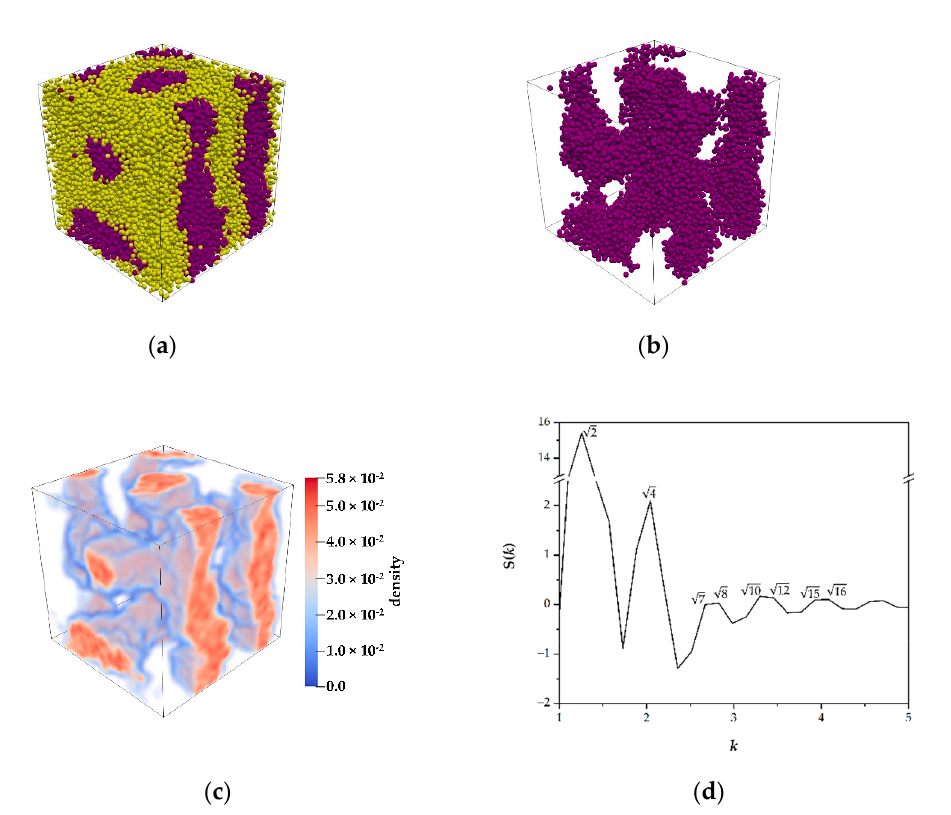
Figure 4. The coarse-grained model obtained from an S 14 I 6 : ( a ) an arrangement of the styrene (yellow) and isoprene (violet); ( b ) isoprene beads resulting solely in a skeleton of gyroidal morphology; and ( c ) a gradient of styrene density. The red regions correspond to high densities of isoprene and vice versa for the blue region. ( d ) The simulated S( k ). Table 1. Eigenvalue and accumulated contribution ratio for the principal components (PCs) using RDF and S( k ) data.